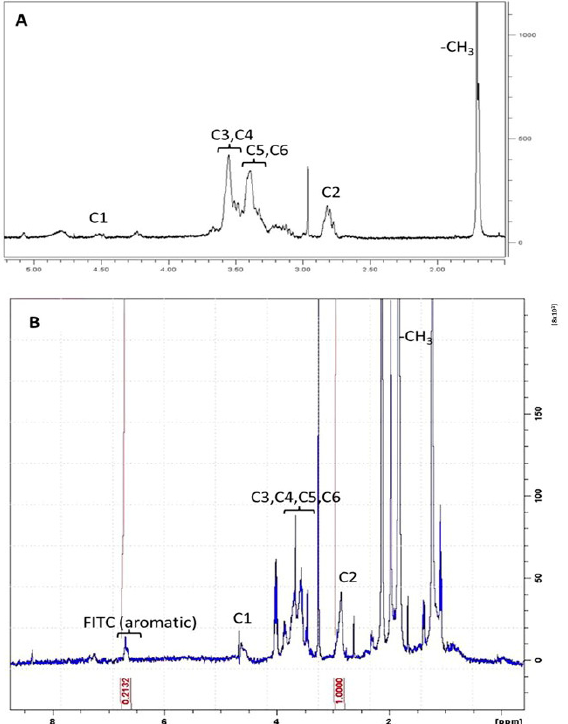
Figure 5. 1 H-NMR spectra of CS ( A ) and CS-FITC conjugate ( B ) in D 2 O acidified with DCl. The signals relating to CS (black line in box A ) and CS FITC(blu line in box B ) and the integrals (black lines in box B ) relating to the diagnostic signals of the two species are reported